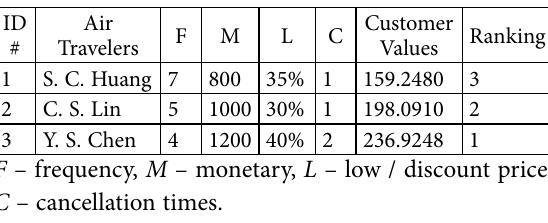
Table 2. Samples of FMLC-CV customer values